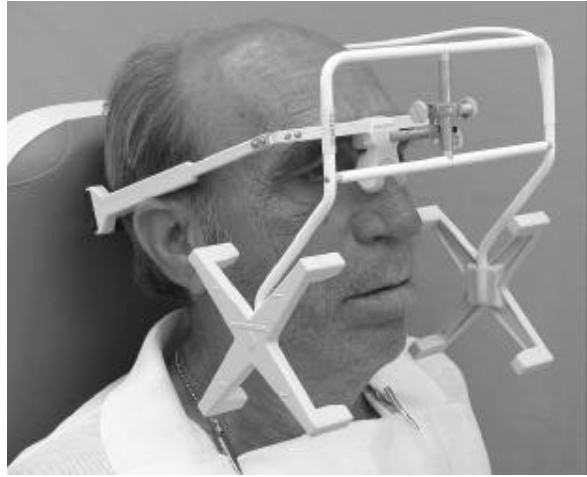
FIGURE 1 - Subject using an array of magnetic sensors.